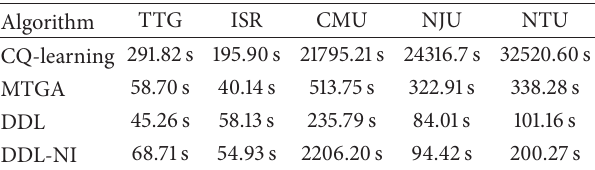
Table 2: The average runtime of the tested approaches in games TTG, ISR, CMU, NJU, and